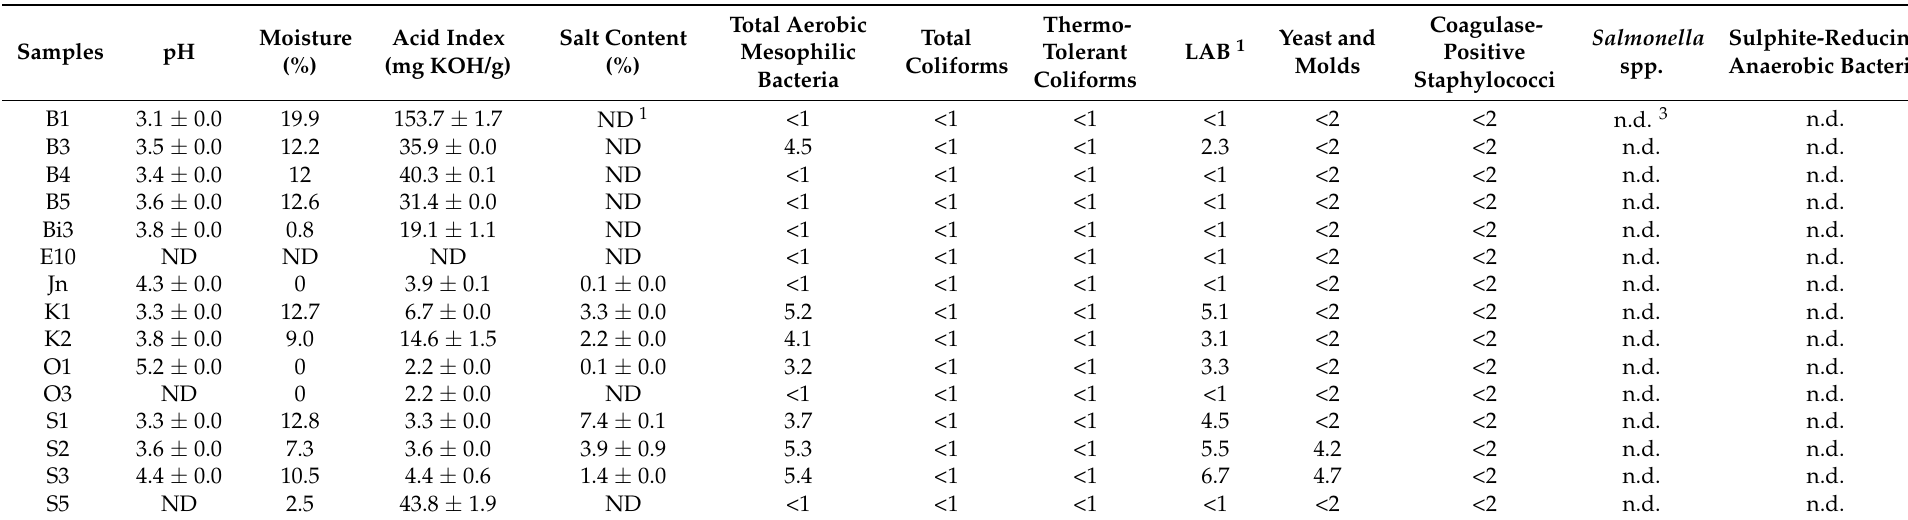
Table 2. Physicochemical properties and microbial counts (log 10 CFU/g) of the fifteen different Smen samples produced in Algerian